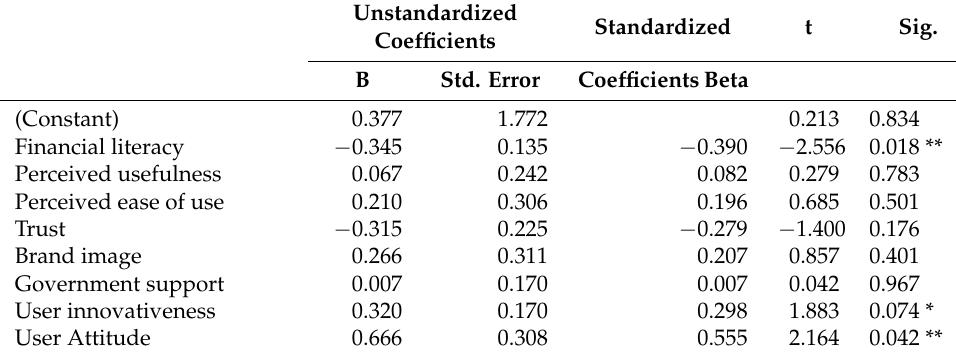
Table 15. Linear regression